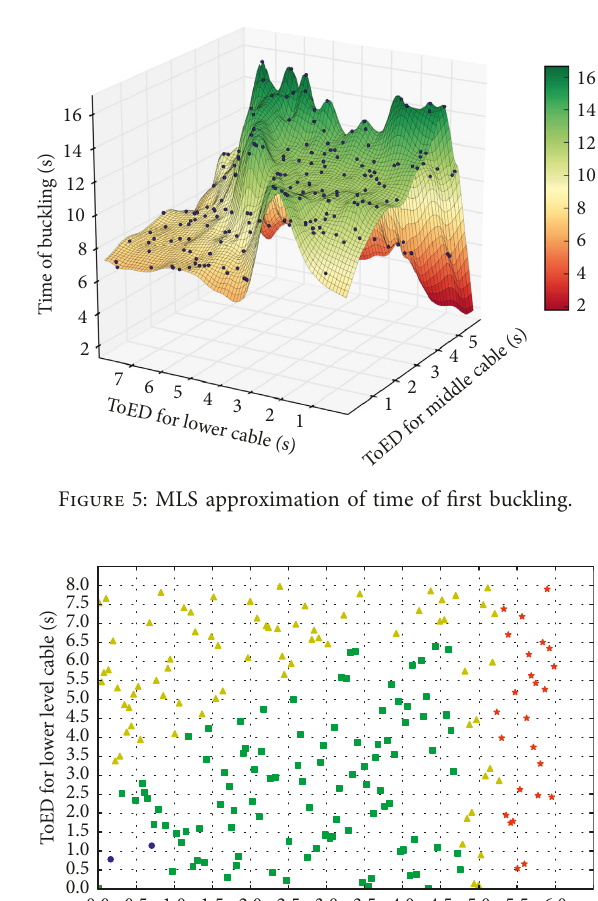
Figure 4: MLS approximation of tip resultant horizontal displacement.